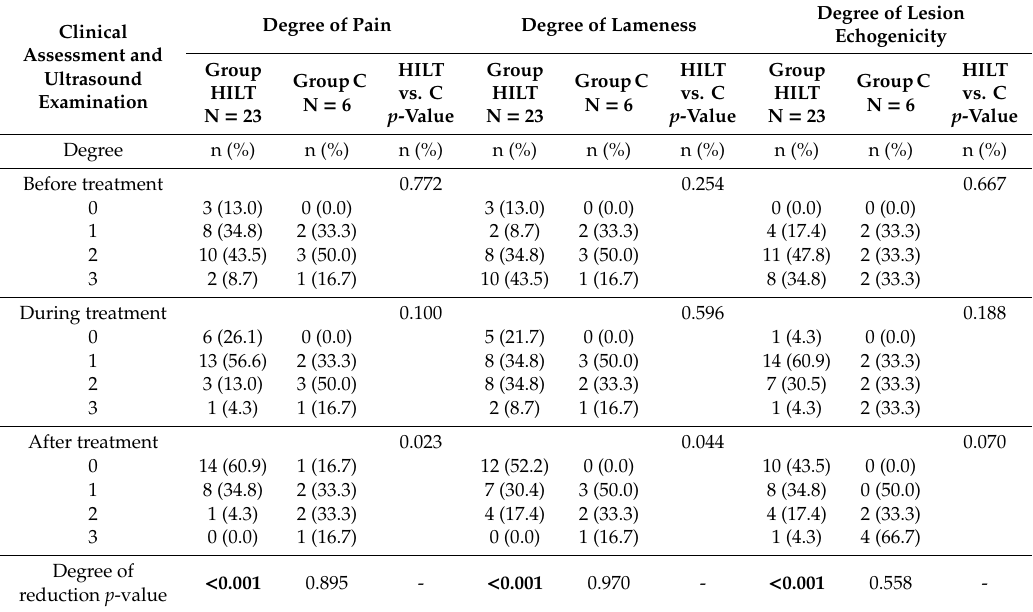
Figure 1. Number (percentage) of horses in groups di ff ering in examination time and degree of pain in the high intensity laser therapy (HILT) group and control (C) group, and the results of the independence test. BT, before treatment (day 0); DT, during treatment (day 13–15); AT, after treatment (day 38–40). Table 1. The effect of HILT on pain, lameness and lesion echogenicity for horses from high intensity laser therapy (HILT) group and control (C) group.